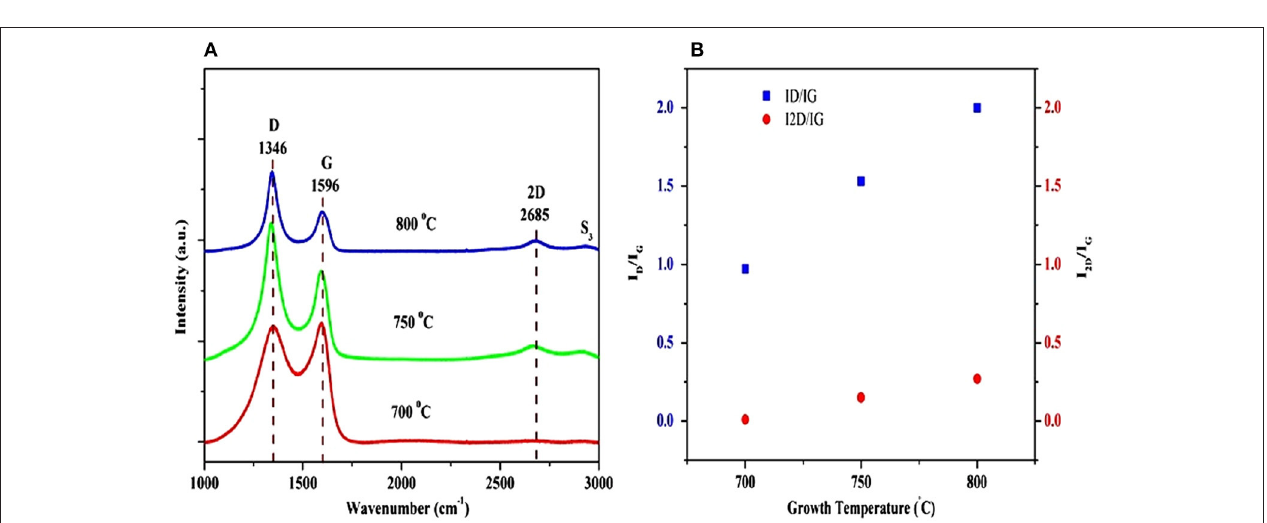
FIGURE 11 | (A) Raman spectra of graphene films deposited on Ni/Si substrate at three different growth temperatures; (B) I D /I G and I 2D /I G intensity ratios of graphene layers as a function of the growth temperature [Reproduced from Kumar et al. (2017) with permission of Springer]. (B) shows the I D /I G and I 2D /I G ratios as a function of growth temperature. Clearly, the intensity ratios I D /I G and I 2D /I G increased with the increase in growth temperature. The I 2D /I G ratio for the graphene film deposited at 750 ◦ C was 0.15, confirming the formation of multi-layer graphene (7–8 layers). The I 2D /I G ratio for graphene films grown at 800 ◦ C was 0.27, corresponding to few-layer graphene (4–5